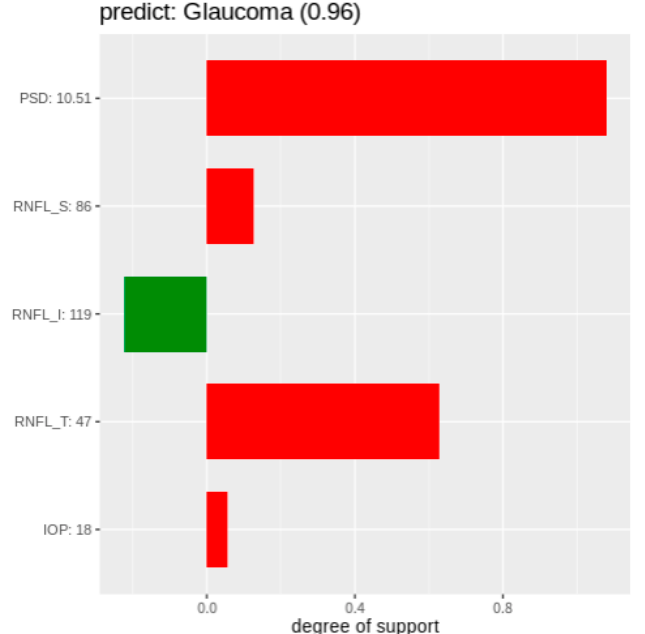
Figure 5. An example of a Shapley Additive Explanations (SHAP) chart.